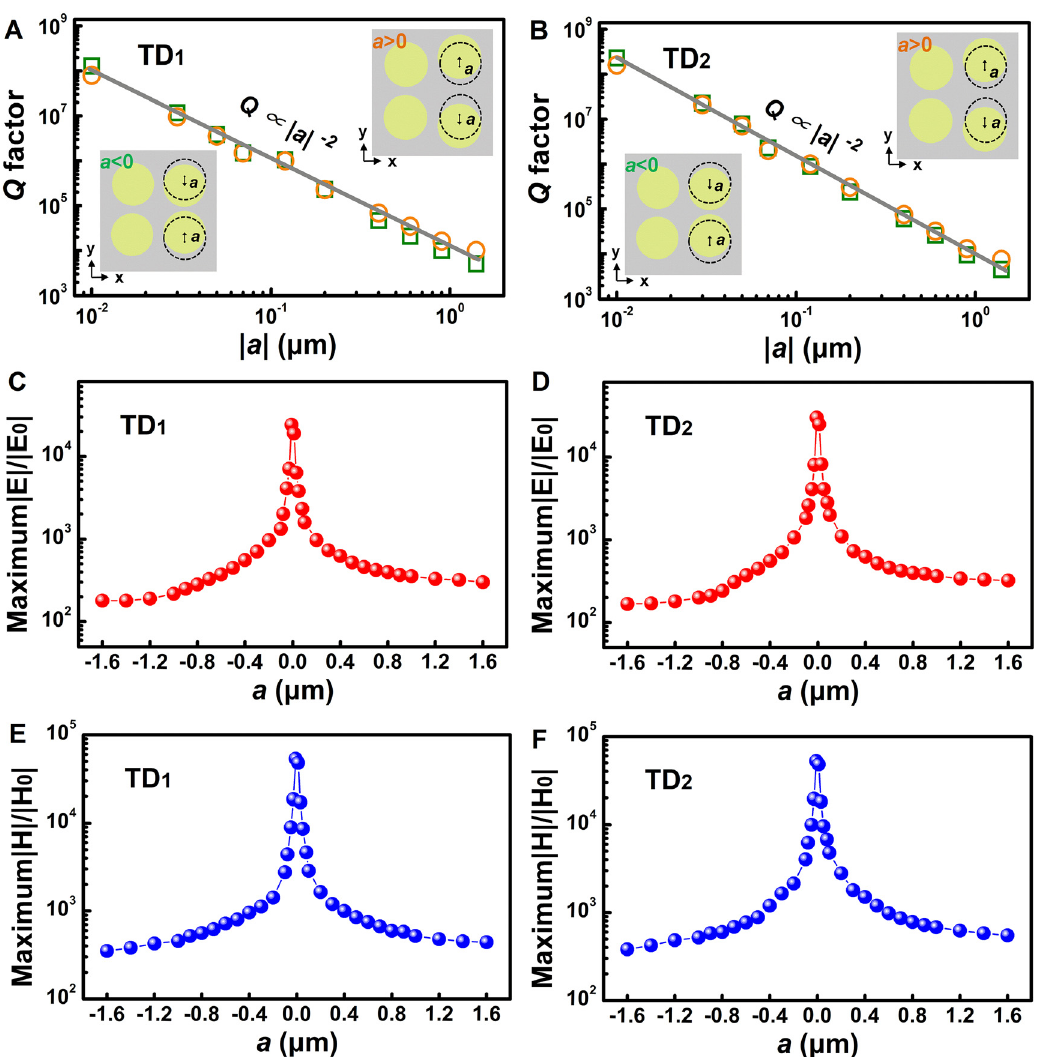
Figure6: Thelog-logplotof Q factorsasafunctionoftheabsolutevalueofasymmetricparameter | a | for(A)TD 1 and(B)TD 2 ,theorangehollow circles represent the case of a > 0 μ m, and the green hollow squares are the case of a < 0 μ m. The gray lines show the inverse quadratic dependenceof | a | .The fi eldenhancementinalogarithmscaleofelectric fi eldfor(C)TD 1 and(D)TD 2 andmagnetic fi eldfor(E)TD 1 and(F)TD 2 at a location of z -axis corresponding to the half-height of the cylinders with respect to the asymmetric parameter a